Question: Compose a caption that would accompany this figure in a paper.
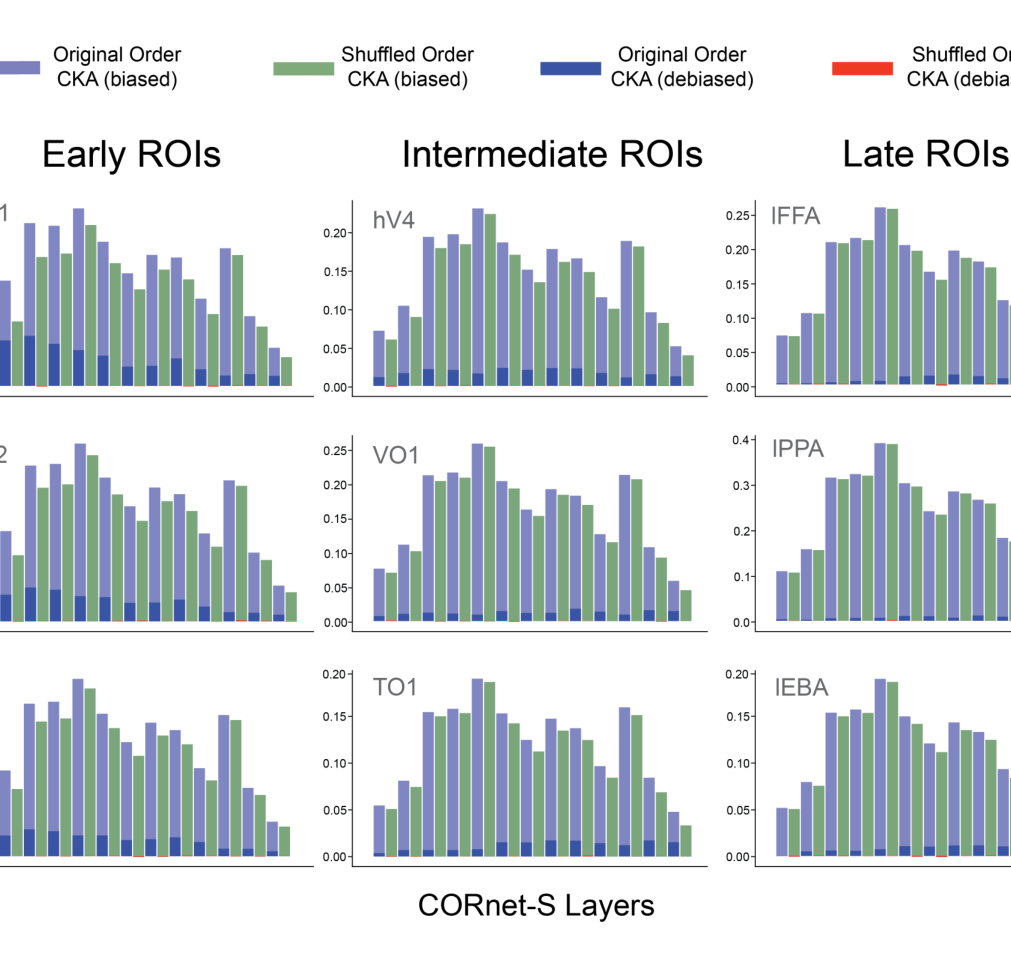
Answer: Across early (V1, V2, V3), intermediate (hV4, VO1, TO1) and late (left-FFA, left-PPA, left-EBA) ROIs, biased CKA is contrasted with debiased CKA across the original data order and the mean of five shuffled versions across three fMRI participants over CORnet-S. Debiased CKA is the only metric that shows sensitivity to stimuli-driven responses and with it we replicate the previously-reported pattern that lower visual areas exhibit greater correspondence to lower-layer CNN representations and similarly for higher visual areas / higher-layer CNNs.